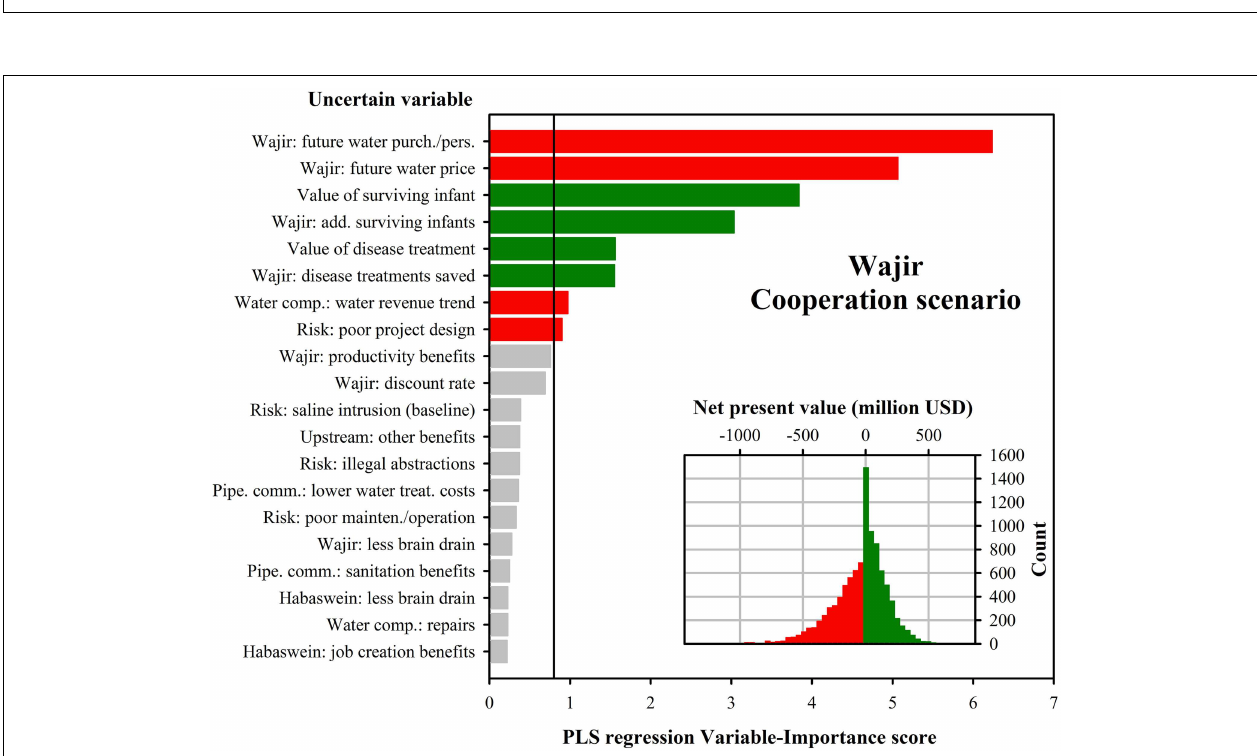
FIGURE 7 | Key sources of uncertainty in projecting outcomes for the residents of Wajir for the “cooperation” scenario, as identified by Partial Least Squares (PLS) regression. For a detailed description of the plots, see legend to Figure 5 .